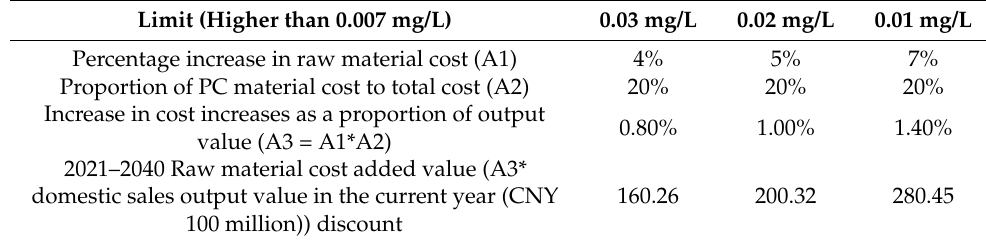
Table 7. Raw material cost expenses due to the limit